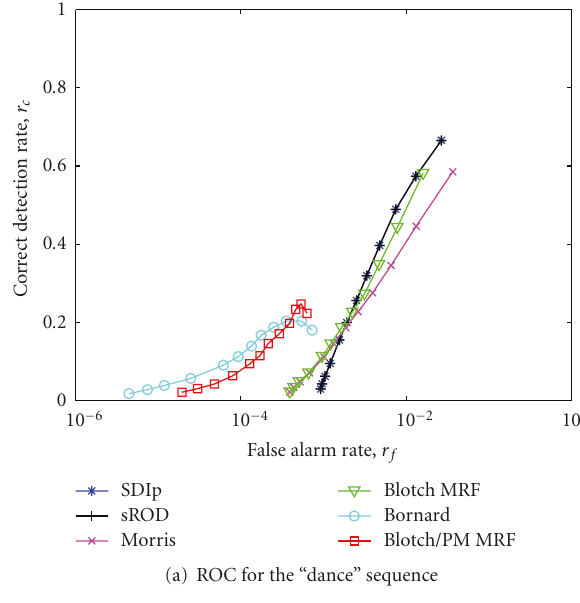
Figure 11: This figure illustrates how lowering the DFD threshold δ t results in a lower correct detection rate. The blue circle highlights a large blotch which is not detected at the lower threshold ((a) and (b)—correct detections in green, missed detections in blue). At the lower threshold this blotch is classified as PM ((c) and (d)—red for PM, green for blotches).